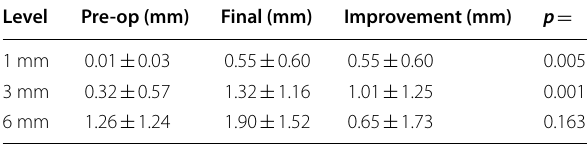
Table 1 Changes of the thickness of the buccal bone wall at the level 1, 3, and 6 mm apical to reference level Level Pre‑op (mm) Final